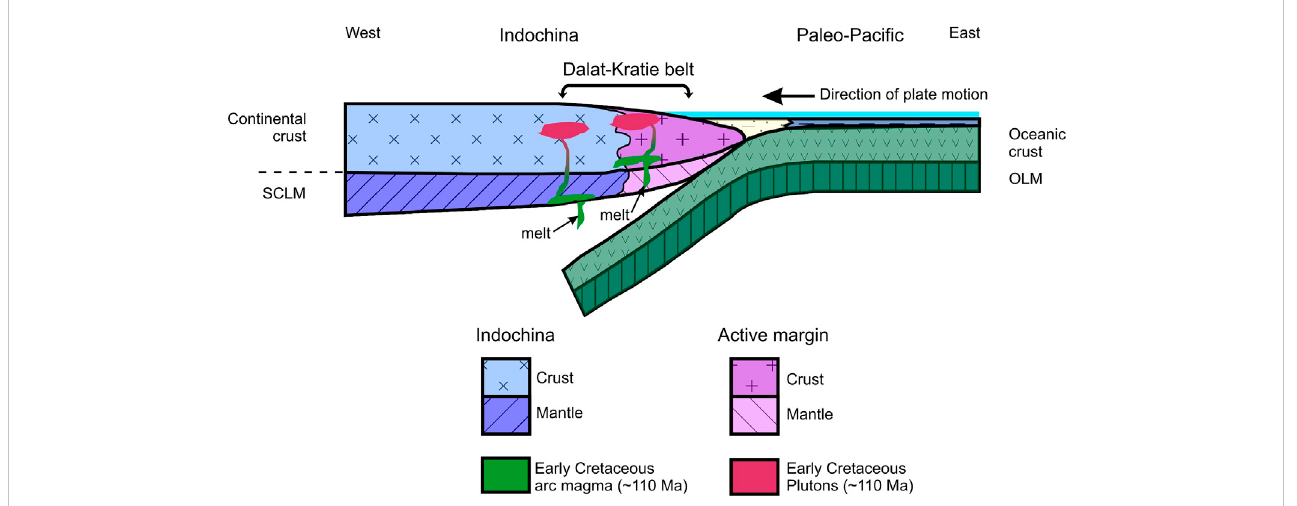
FIGURE 14 Conceptual model for the genesis of the Cretaceous (130-90 Ma) volcanic-arc granites of the Dalat-Kratie belt. Subduction of the Paleo-Paci fi c plate beneath the Indochina terrane belt generates arc magmas that may be derived from the subducted slab, lower crust, or from mixed crustal/mantle sources. Thegraniticplutonscloser(purpleregion)toarcfrontaremorelikelytobeisotopicallyenrichedwhereasthoselocatedfarther(blueregion)fromthearcfront are more likely to be isotopically juvenile. It is possible that the isotopic differences are an intrinsic feature of the Indochina terrane and that there may exist a domain boundary within the southeast Indochina